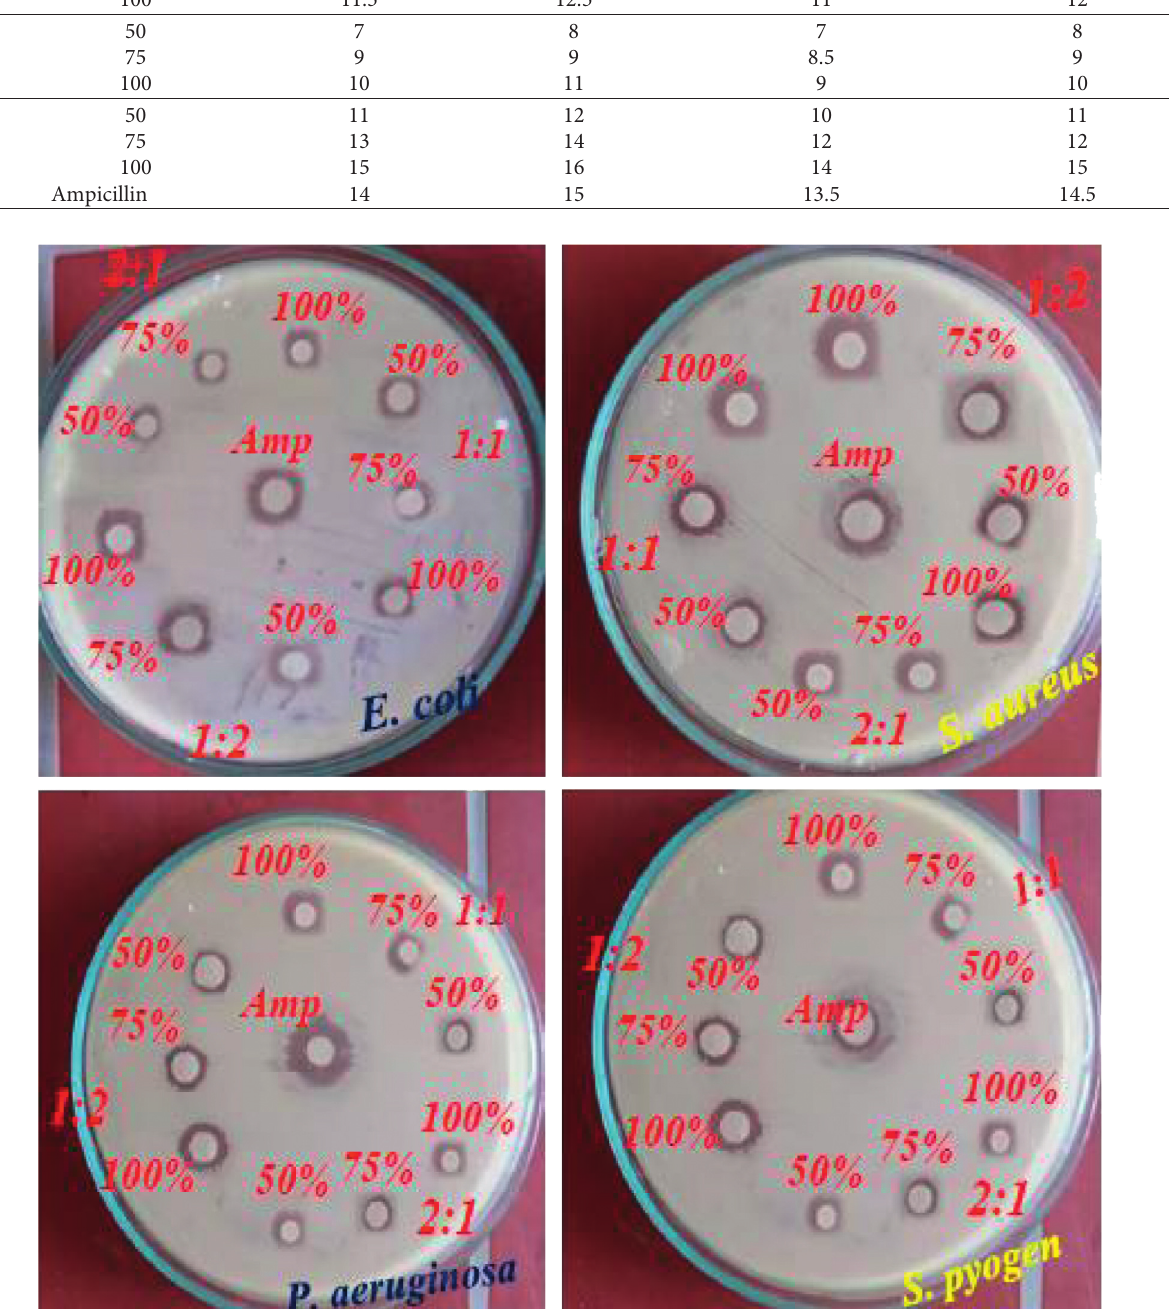
Figure 12: Zone of inhibition of green Co 3 O 4 (1:2, 1:1, and 2:1) nanodrugs against E. coli , S. aureus , P aeruginosa , and S. pyogenes at 50, 75, and 100mg/mL